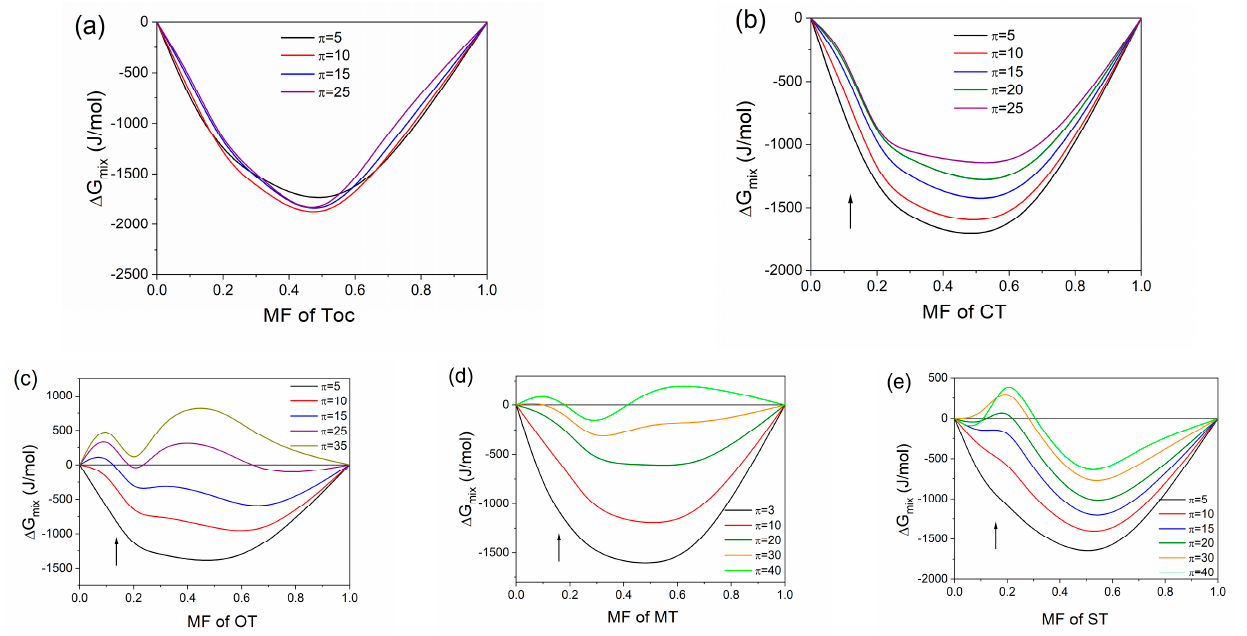
Figure 6. The total free energy of mixing ∆ G mix versus mole fraction of ( a ) Toc, ( b ) CT, ( c ) OT, ( d ) MT, and ( e ) ST as a function of monolayer composition at different surface pressure, as shown in legend.